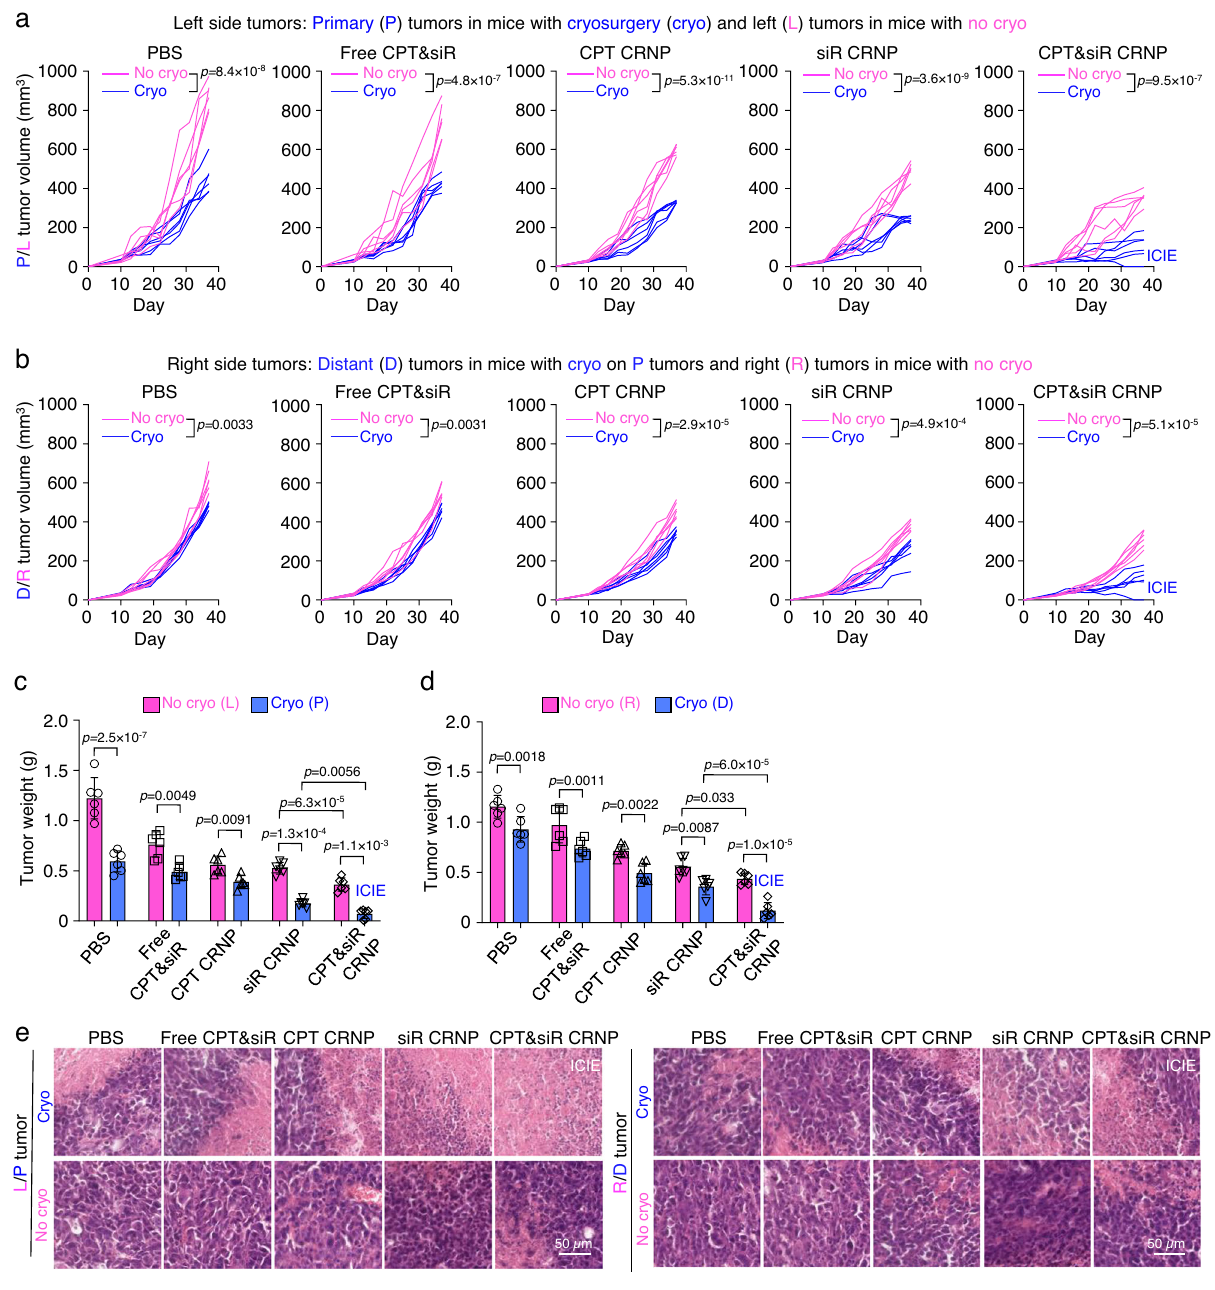
Fig. 7 | ICIE effectively inhibits tumor growth in both primary and distant tumors with no evident systemic toxicity. a Tumor growth curve of left-side tumors including primary (P) tumors from mice with cryosurgery and left (L) tumors from mice without cryosurgery ( n =6 mice). The mice were also injected with one of the formulations including: PBS,free CPT&siR,CPT CRNPs, siR CRNPs, or CPT&siR CRNPs. b Tumor growth curve of right-side tumors including distant (D)tumorsfrommicewithcryosurgeryonPtumorsandright(R)tumorsfrommice without cryosurgery ( n =6 mice). The mice were also injected with one of the indicated formulations. c , d Weight of left-side (L versus P, c ) and right-side (R